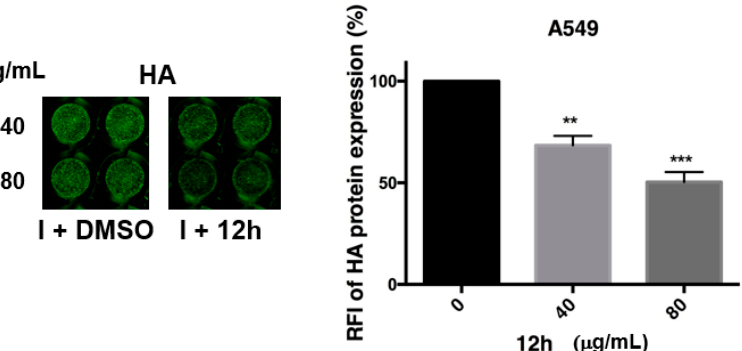
Figure 6. The expression of Hemagglutinin (HA) by means of ICW assay at late steps of viral replication. A549 cells were infected with PR8 and treated or not with 40 or 80 µ g/mL of compound 12h . After 24 infection, cells were fixed and stained for HA protein, as described in the Materials and Methods section. The expression of viral HA was analyzed by ICW assay, using LI-COR Image Studio Software. The percentage of relative fluorescence intensity (RFI) was calculated in comparison to untreated infected cells (considered 100%). Values are the mean ± S.D. of two experiments, each performed in duplicate (n = 4). Statistical significance of the data vs untreated infected cells was defined as ** p < 0.001 and *** p < 0.0001.